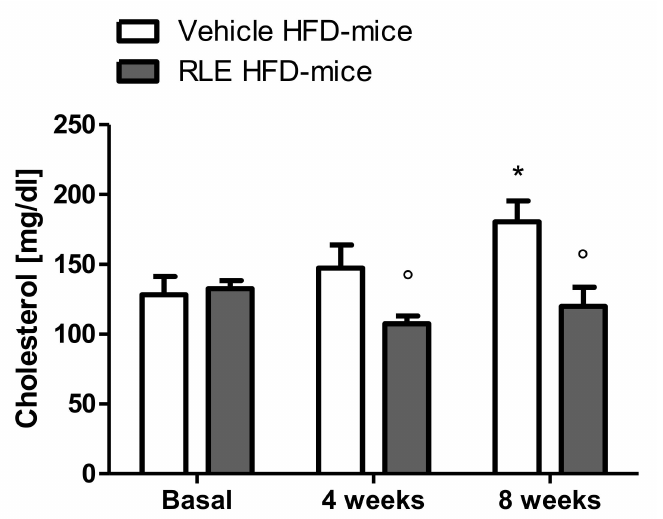
Figure 2. Eight weeks of RLE diet supplementation reduce cholesterol blood concentration in HFD- mice. RLE diet supplementation was able to block blood cholesterol increase in CD1 mice fed on a high-fat diet (HFD-mice) after four and eight weeks of treatment. Data are means ± SEM of 9 to 12 mice per group. Two-way ANOVA followed by Bonferroni post-test. * p < 0.5 vs. vehicle HFD-mice basal group; ◦ p < 0.5 vs vehicle HFD-mice 8 weeks